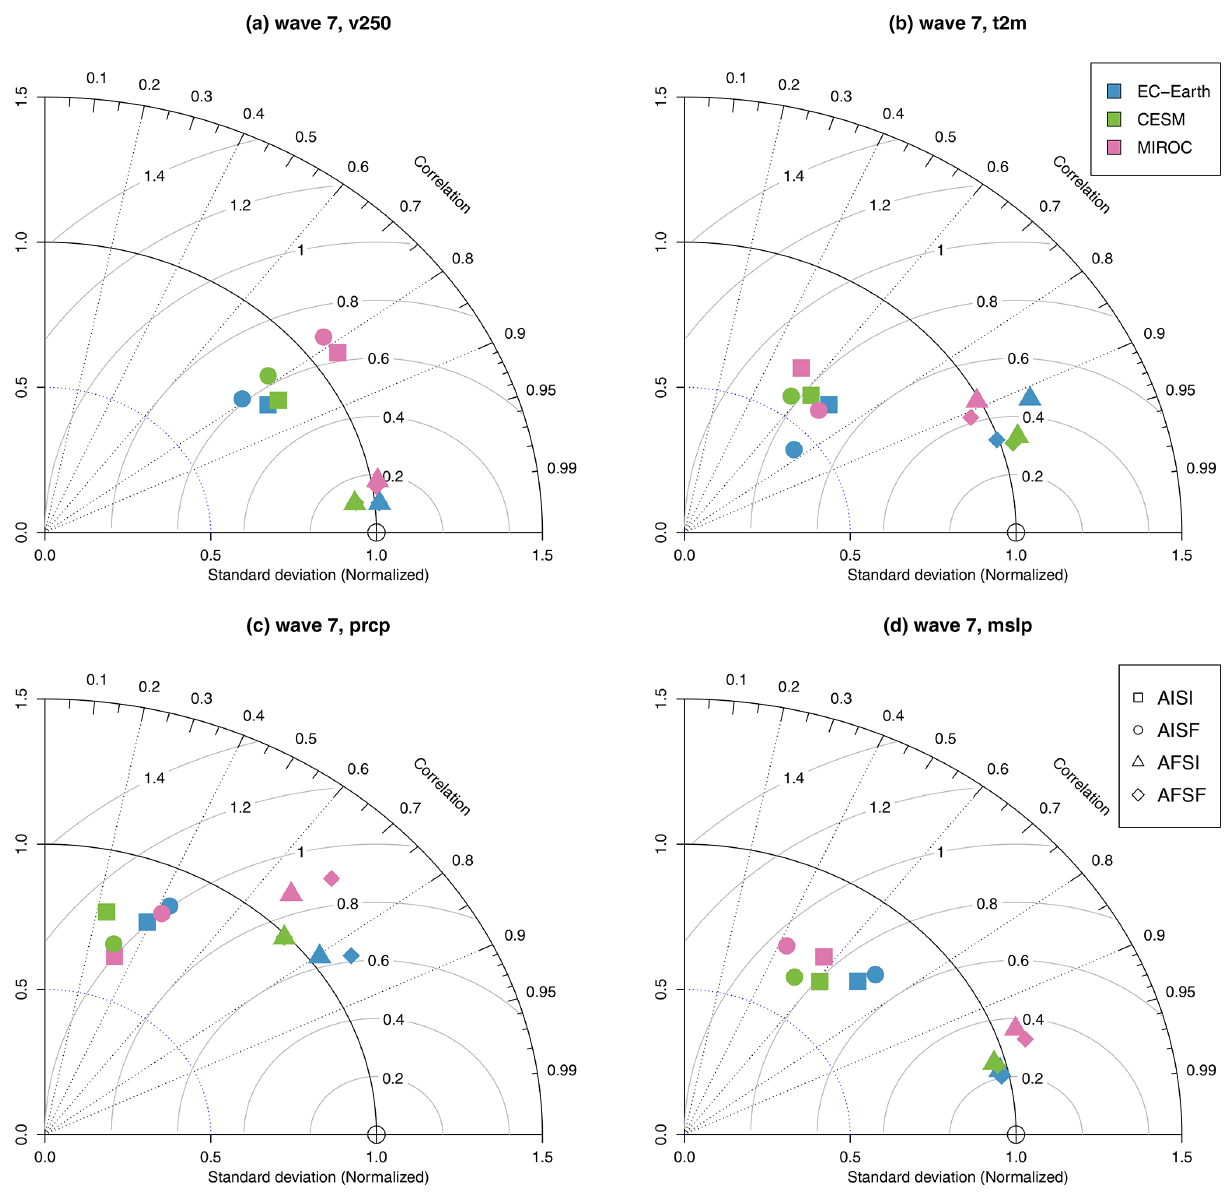
Figure 6. Taylor diagram for all experiments in models compared to ERA5 for wave-7 events and episodes. For (a) v250, (b) t2m, (c) prcp, and (d) mslp, the Taylor diagram presents three statistics for each model and each experiment: the Pearson correlation (dashed lines), the RMSE (gray contours), and the normalized spatial standard deviation (solid black